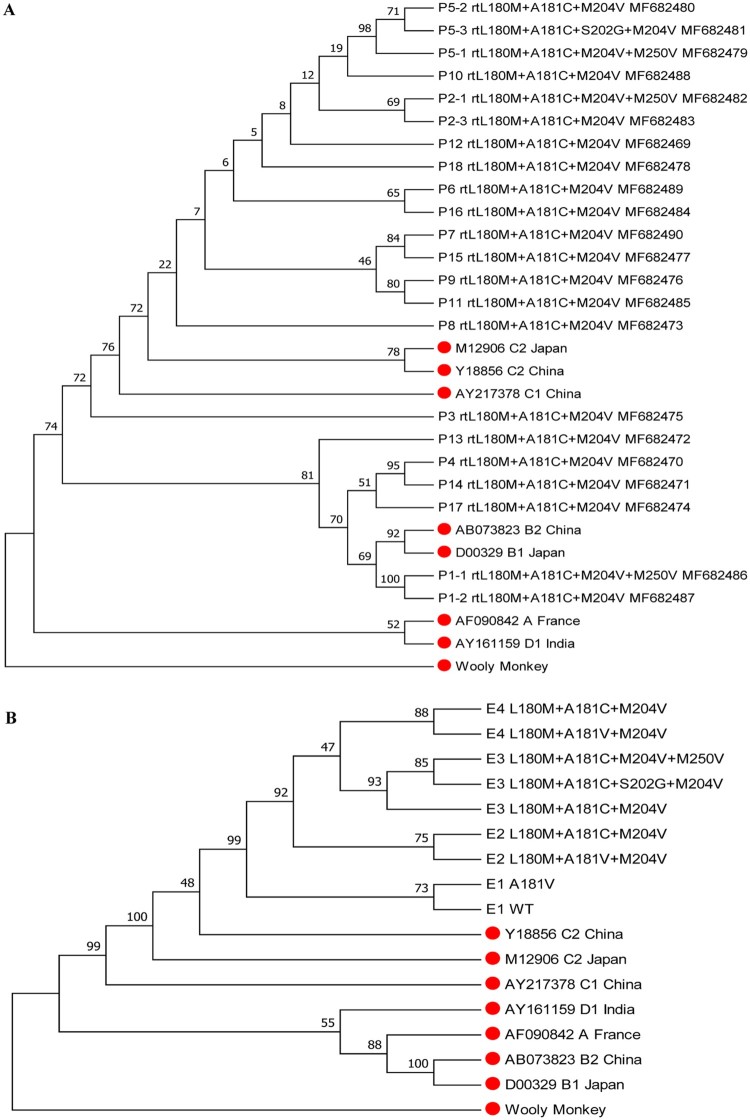
Phylogenetic tree analysis for HBV RT sequences from rtA181C-positive patients. (A) Analysis for 22 RT sequences containing rtL180M+A181C+M204V mutations from the 18 patients. P represents patient. (B) Analysis for nine RT sequences from serial serum samples of a representative patient (patient 5). The reference sequences are marked with red solid circle.